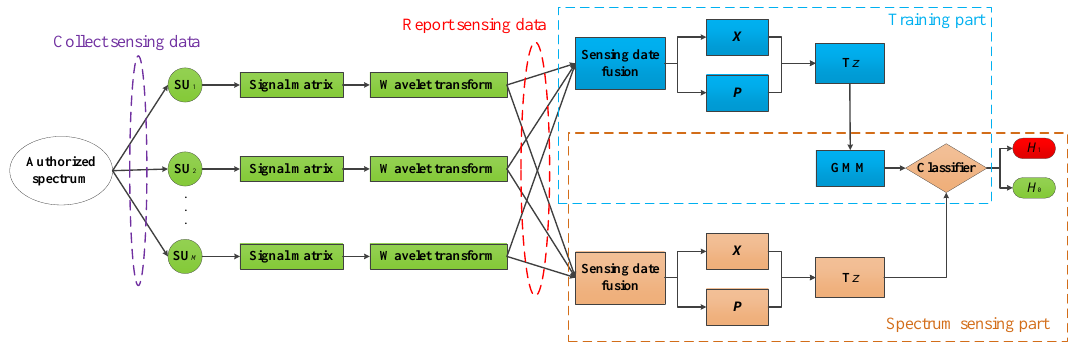
Figure 2. Spectrum sensing system model based on